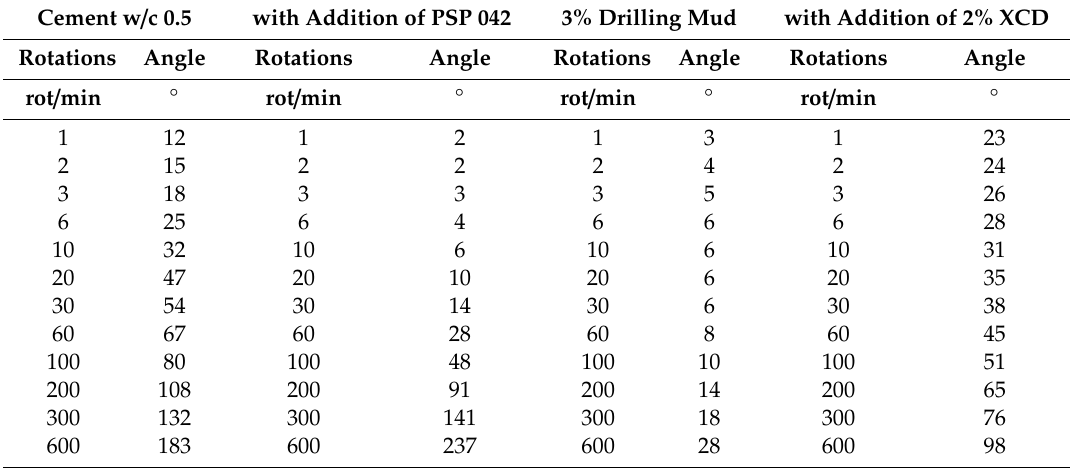
Table 1. Data from laboratory tests made on a Fann viscometer (R1-B1, F1). Cement w / c 0.5 with Addition of PSP 042 3% Drilling Mud with Addition of 2% XCD